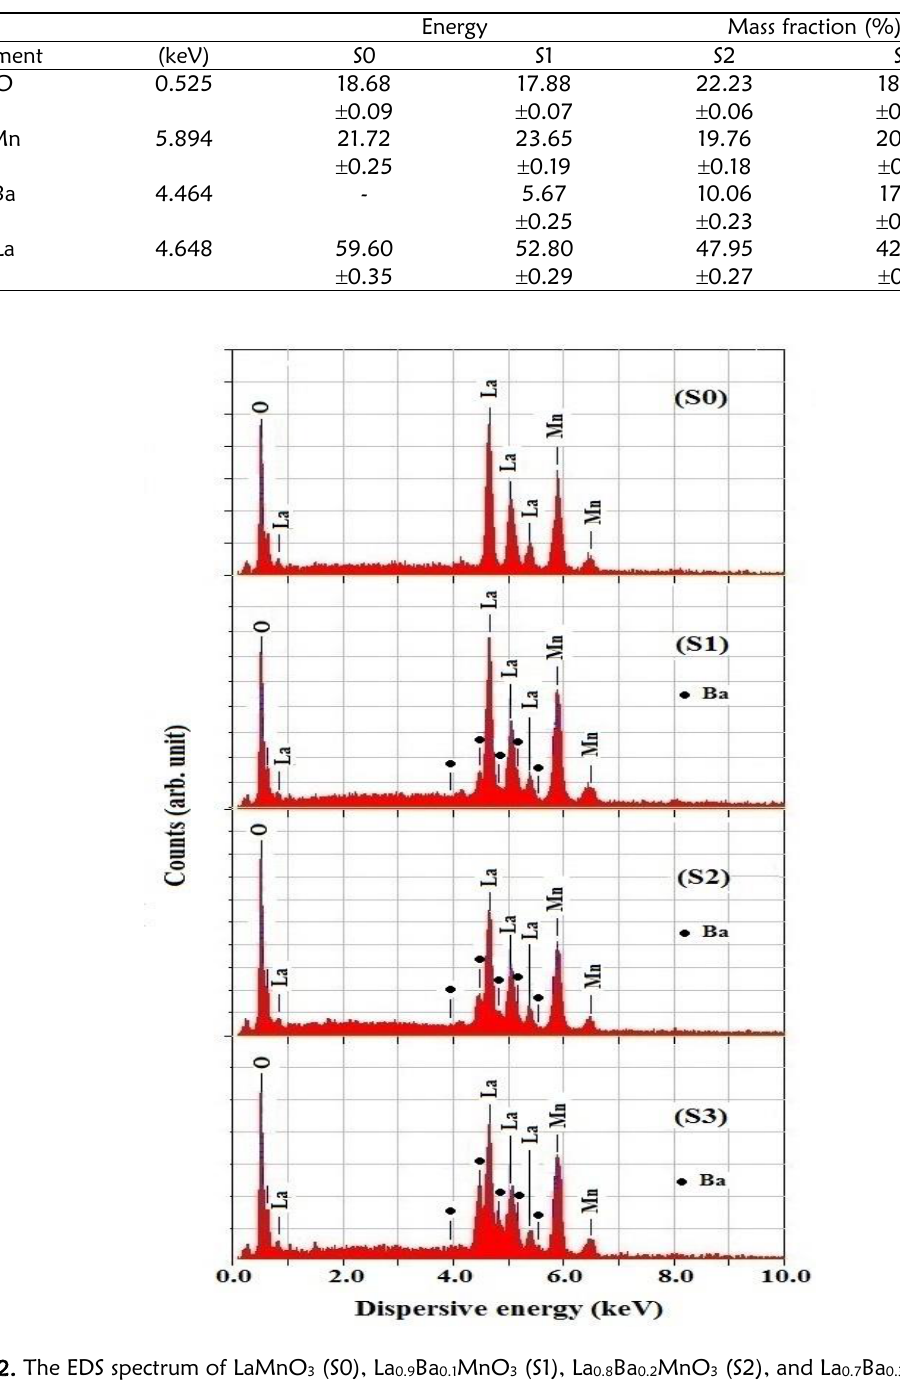
Table 5. The mass fraction of O, Mn, Ba and La elements in S0, S1, S2, and S3 samples.